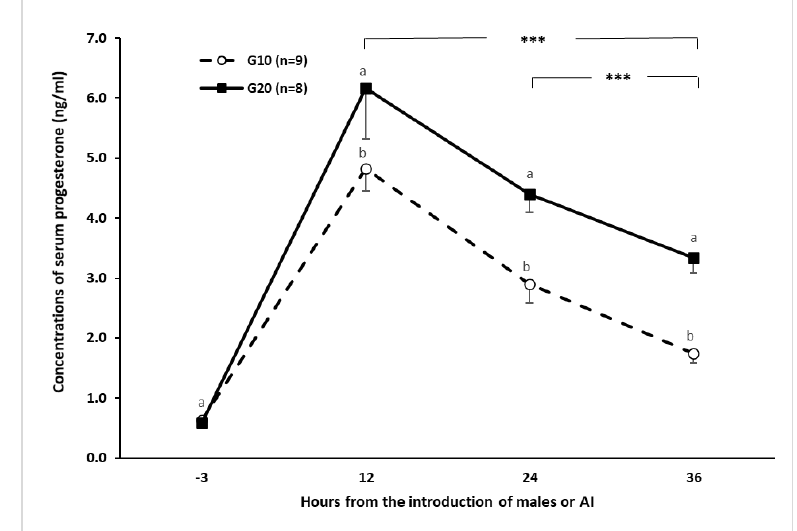
Figure 3. Mean serum progesterone concentration in goats treated with 10 or 20 mg of progesterone